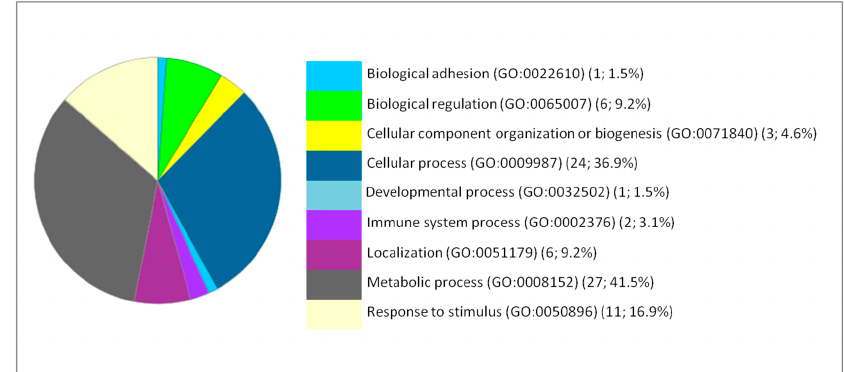
Figure 2. Functional classification of the 66 differentially expressed proteins in the liver following IONP exposure according to the biological processes. The pie chart was generated from PANTHER Classification System. The number and percentage are given based on the 66 proteins. Biological process name (GO: Gene Ontology class ID) (number of proteins; percentage from 66